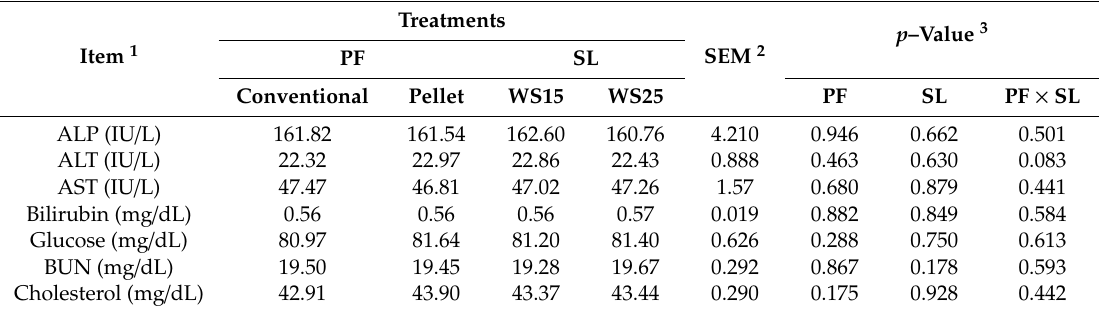
Table 7. E ff ects of experimental diets on serum enzymes and on bilirubin and blood metabolites in fattening goats fed conventional and pelleted total mixed rations with two levels of wheat straw. Treatments Item 1 SEM